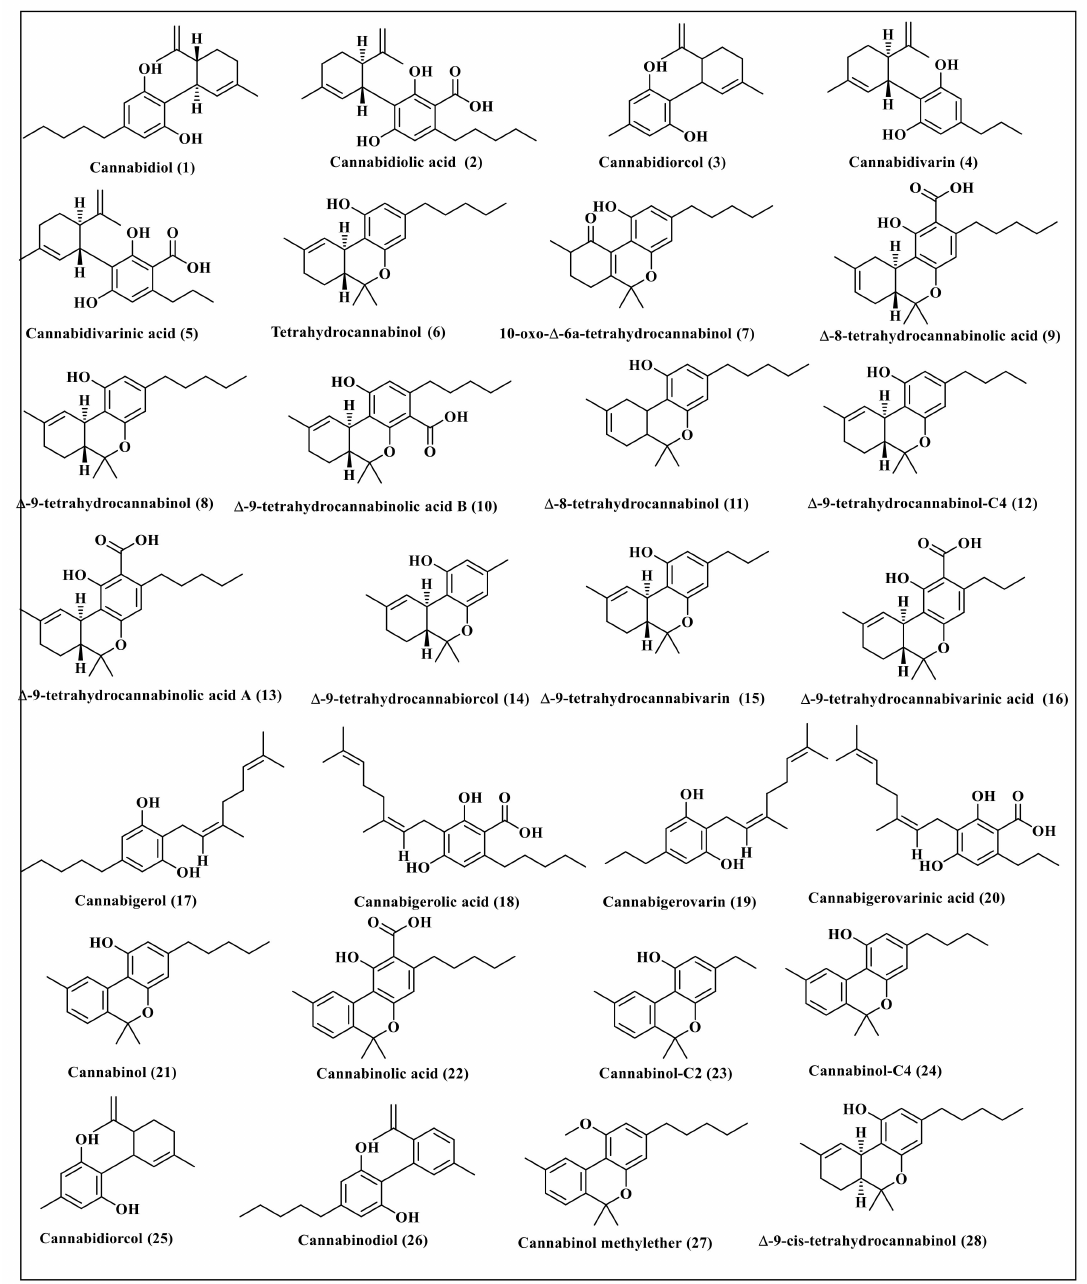
Figure 1. The chemical structures of some of the major cannabinoids present in Cannabis sativa